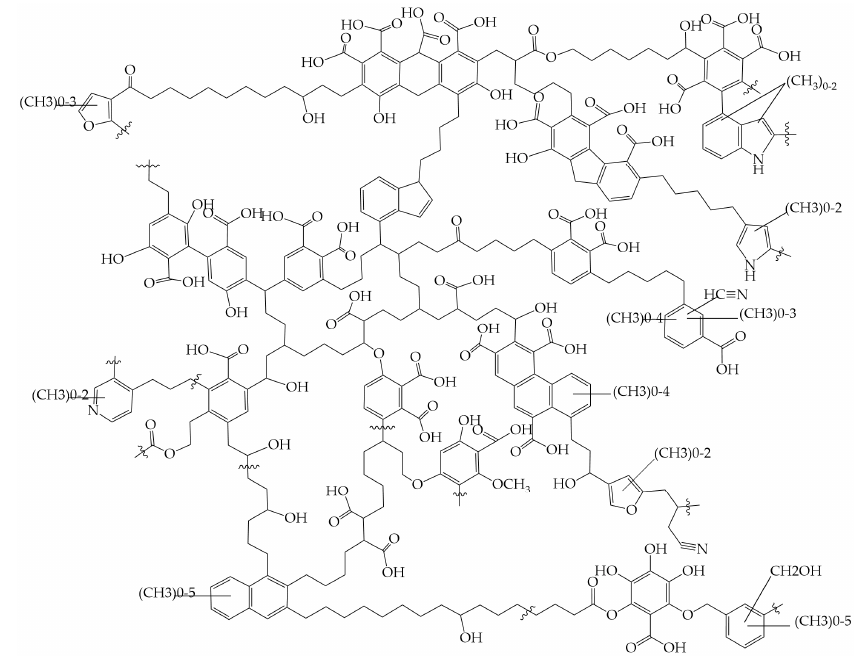
Figure 4. The humic acids molecular structure model proposed by Schulten [68]. HA and FA molecules rely on a large number of active functional groups to generate adsorption forces such as ligand exchange and electrostatic interaction with Fe 2+ /Fe 3+ on the surface of mineral particles [69], while with the increase in HA content, colloid action is enhanced, which adheres to and wraps around mineral particles, resulting in enhanced bridging between mineral particles and tight agglomeration, thus substantially increasing the green pellet strength [70,71]. Numerous studies have shown [72,73] that the adsorp ‐ tion concentration of HA on magnetite/hematite increases with increasing HA concentra ‐ tion and decreases with increasing pH [74], while metal cations change the stretching and curling of FA molecules, leading to the cohesion of FA together, thus increasing the vis ‐ cosity of FA solution and promoting bridging between FA and magnetite surfaces, allow ‐ ing more FA to be adsorbed on the mineral surface [75]. Therefore, the viscosity and ad ‐ sorption density of humic acid ‐ based pellet binder can be increased by adjusting the pH and concentration of the HA/FA solution or adding metal cations to obtain better green pellet strength [76]. 3.3.2. The Application Effect of HA and FA in the Pellets Compared with other organic binders, humic acid binders are not only inexpensive but also generally have high strength of fired pellets, as shown in Table 3. Modified humic acid binder (MHA) are organic polymers prepared by alkalizing weathered coal and lig ‐ nite with surface active and colloidal properties, which can reduce the surface tension of water, improve the hydrophilicity of minerals, adsorb on mineral surfaces by chemical bonding, and have good thermal stability [77].